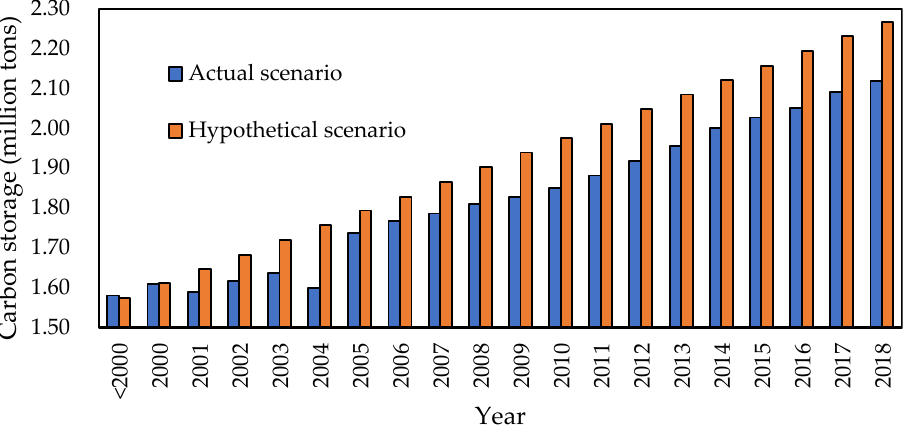
Figure 10. Annual changes in carbon storage for Loei Province from 1999 to 2018 under actual planted and hypothetical non-rubber-planted scenarios.